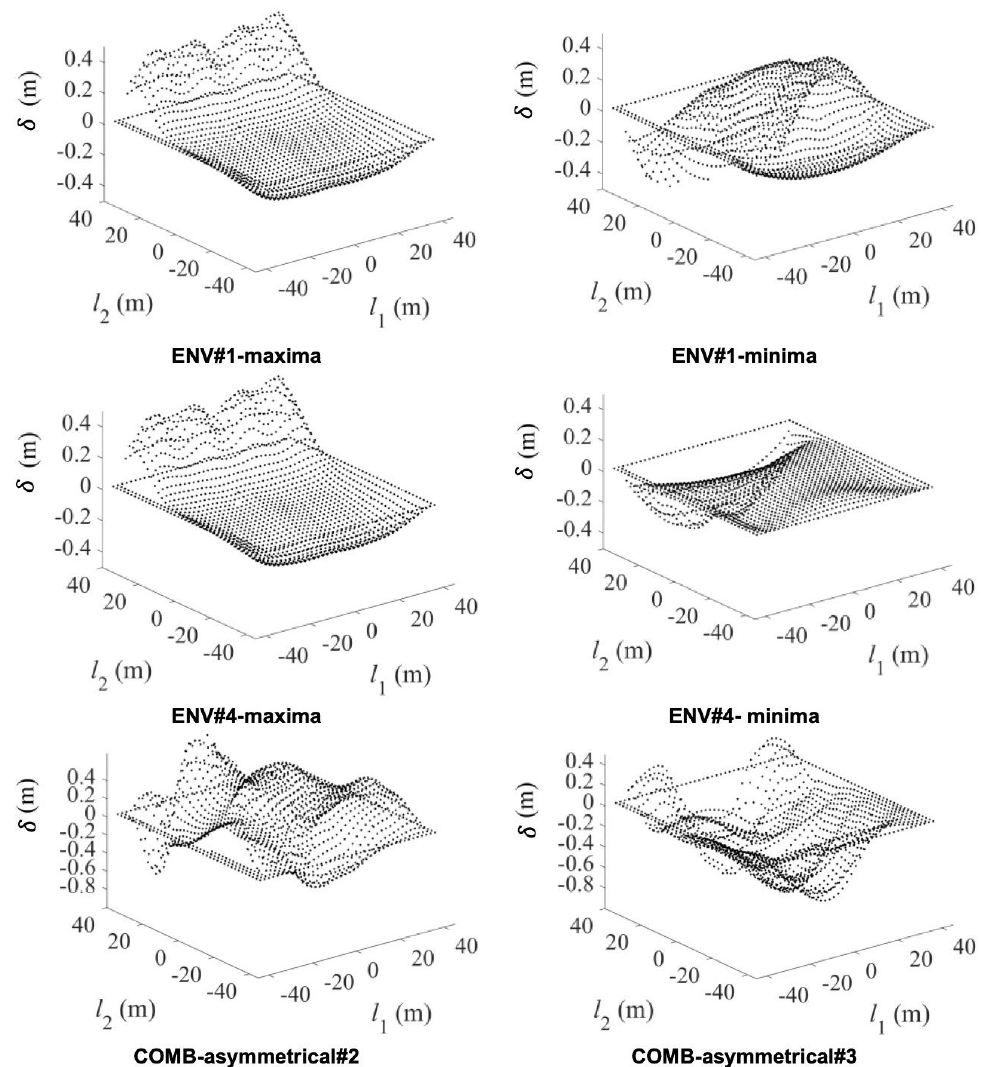
Figure 22: Cable net vertical displacements by FEM analyses by proposed pressure wind load combinations given by modified mean pres- sure coeflcients